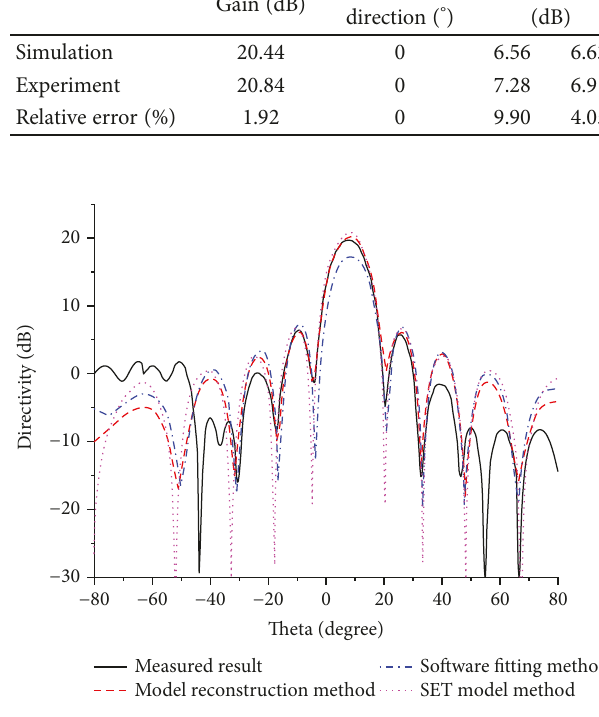
Figure 18: Radiation pattern in the coupling fi